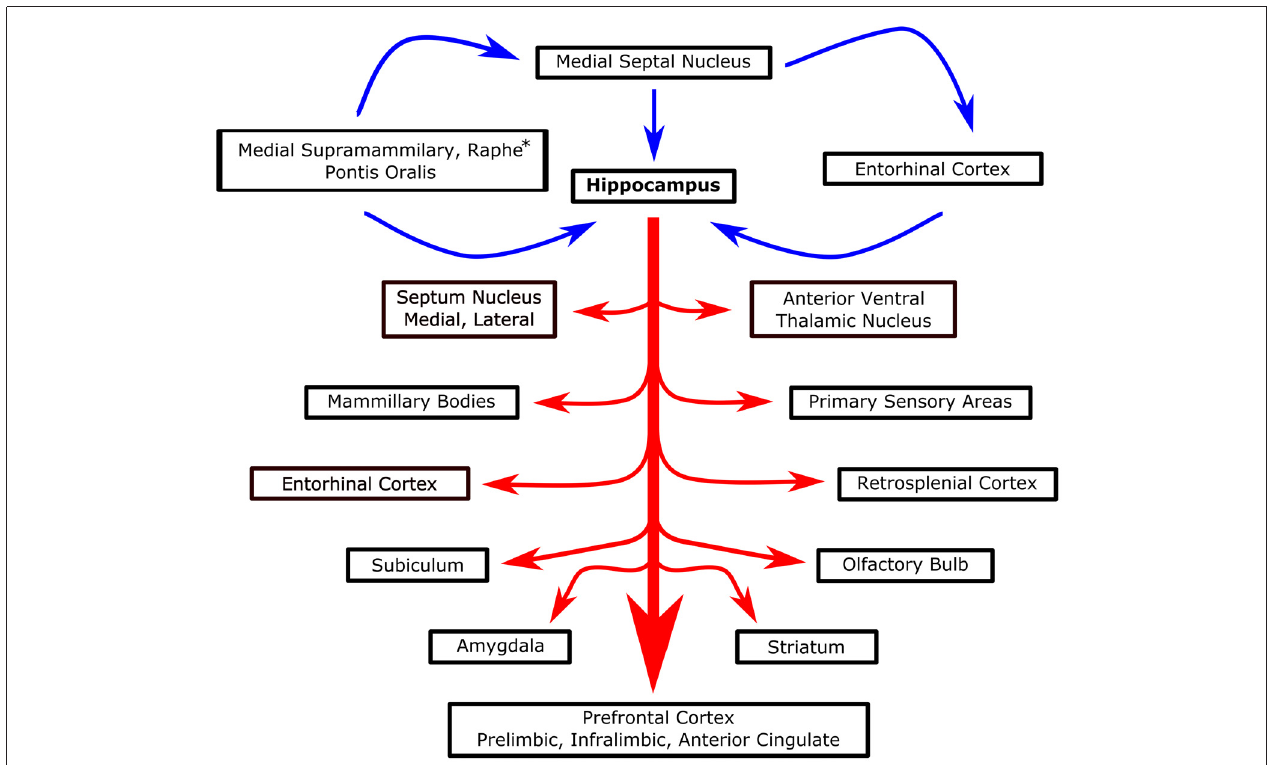
FIGURE 4 | Systems level overview of septohippocampal theta . Blue arrows represent proposed theta generators and essential modulators of hippocampal theta. Red arrows, stemming from the hippocampus, represent various structures that are known to be modulated/interact with hippocampal theta. ∗ Raphe only projects to the hippocampus, not